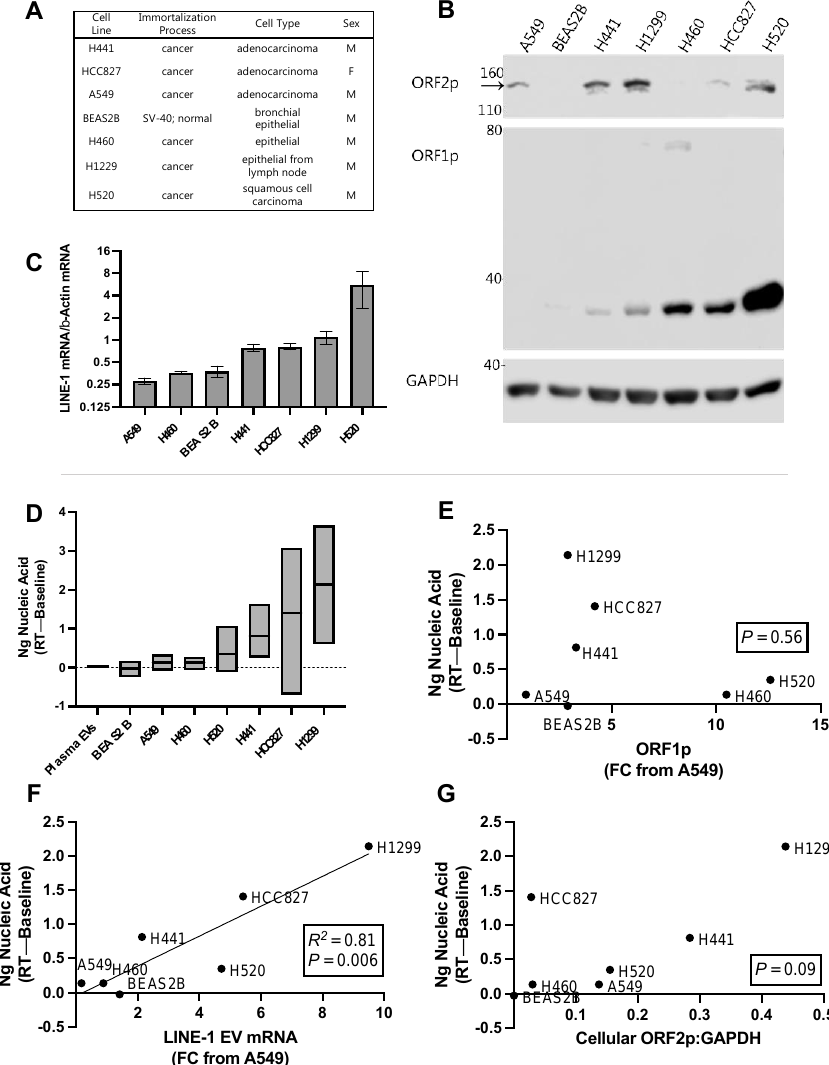
Figure 7. Relationship between Long Interspersed Element-1 (LINE-1) components and reverse transcriptase activity (RT) in extracellular vesicles (EVs) from lung cancer cell lines. ( A ) Characteristics of one normal (BEAS2B) and six cancer cell lines used in the experiment. ( B ) Cellular ORF1p and ORF2p expression. Representative Western blot using 75 μg protein depicting quantities of cellular ORF1p and ORF2p. The ORF2p band is the top band, indicated by the black arrow. ( C ) Quantification of cellular LINE-1 mRNA levels using One-Step RT-qPCR (Mean, SEM shown). ( D ) EVs from three independent cultures and EV collections were measured for RT activity (min, max, and mean shown). RT activity from the plasma donors in 6F are shown for reference (“Plasma EVs”). LINE-1 components in EVs using an ORF1p ELISA and One-Step RT-qPCR. These measures